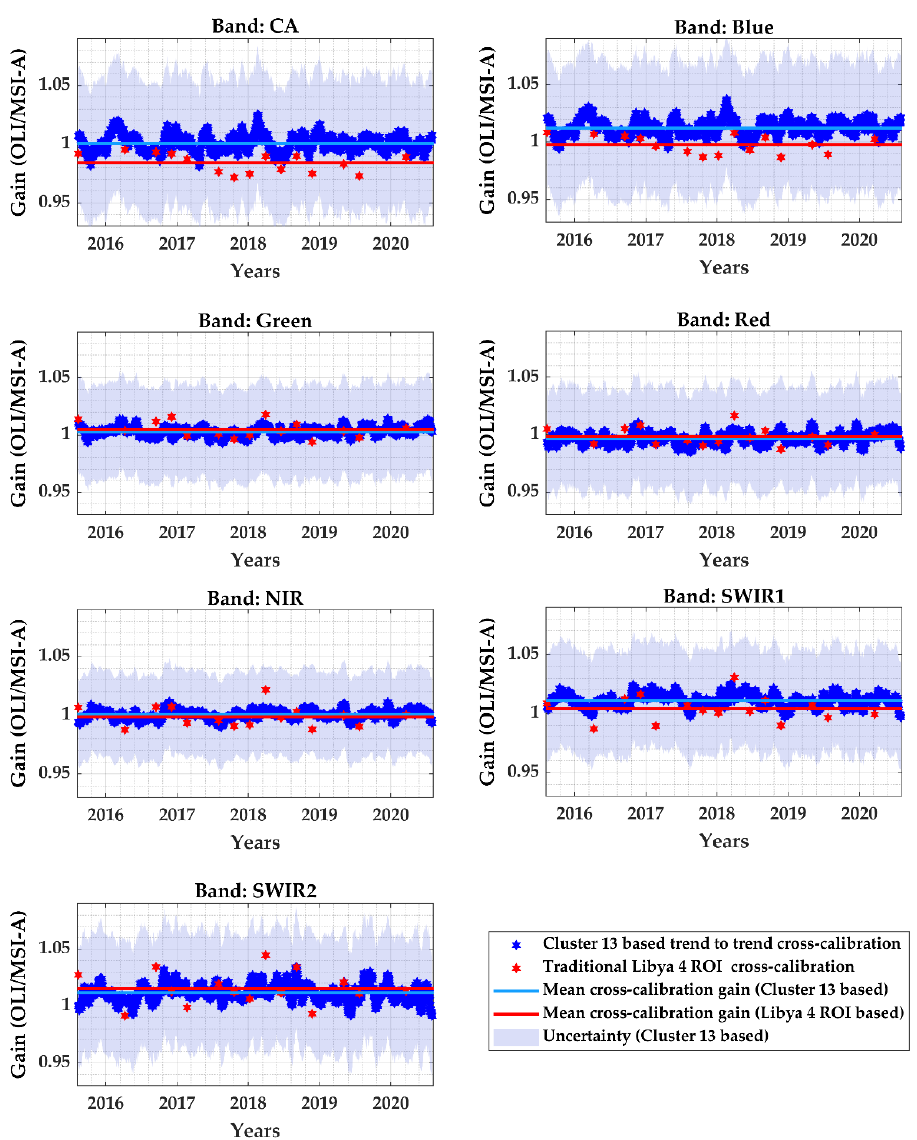
Figure 18. Comparison of Landsat 8 and Sentinel 2A MSI cross-calibration gain ratio with cluster and PICS-based